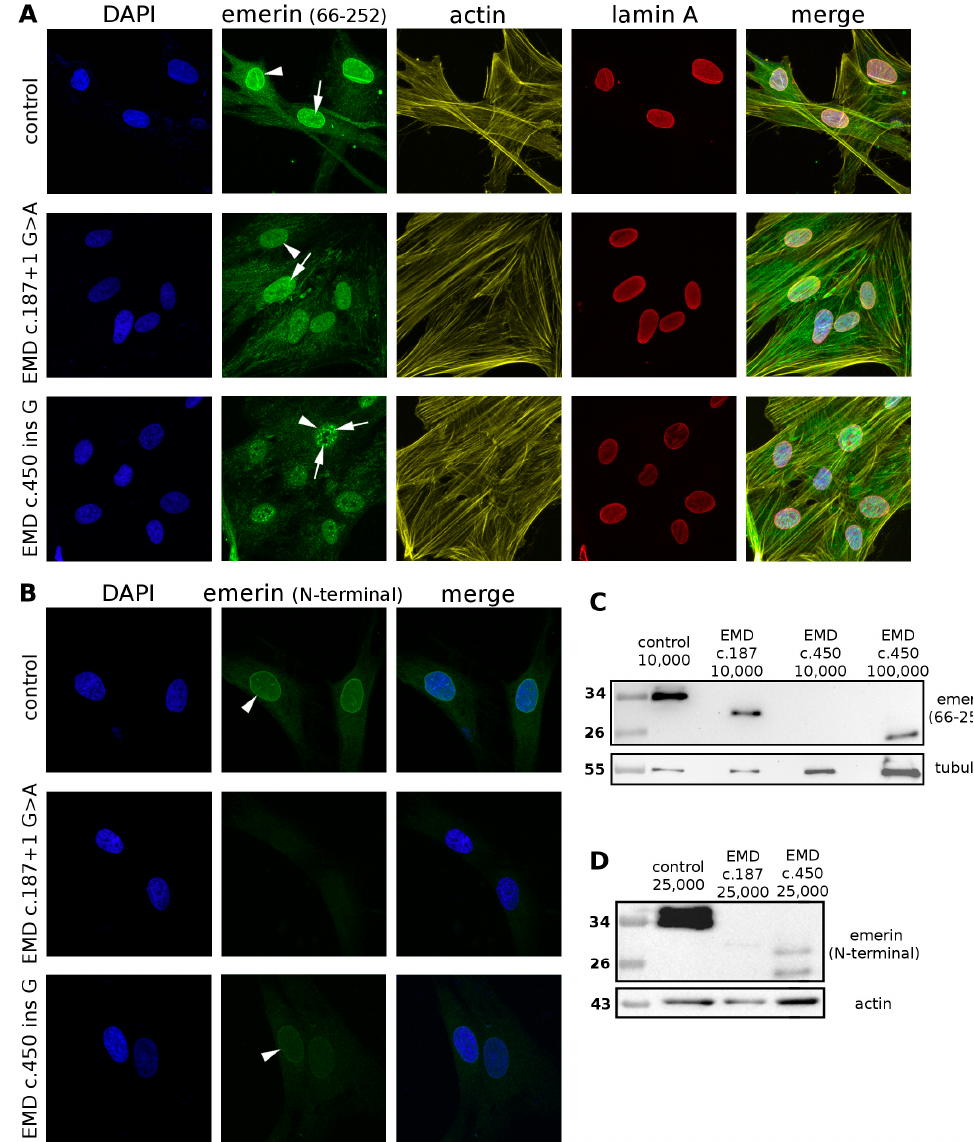
Figure 7. Selected different “emerin-null” patient cells express emerin mutant protein and show abnormal emerin location. Emerin distribution and presence in NHDF and fibroblast obtained from patients with EDMD1. EDMD1 patient cells have shortened emerin with abnormal localization or lower levels. ( A ) Immunofluorescence staining with antibodies recognizing 66–254 aa of emerin indicates changes in the distribution of this protein (emerin diminishing in nuclear rim) in patients bearing mutations c.187 + 1G > A (P2) and c.450insG (P6) in comparison to normal cells. Mutants of emerin do not affect the shape of nuclei (staining for lamin A) or actin filament structure. ( B ) Staining with antibodies recognizing the N-terminus end of emerin indicates lack of epitope in the N-terminal fragment in a patient sample with the mutation c.187 + 1G > A (P2) and shows proper but weaker staining of emerin in the nuclear envelope in a patient sample with the mutation c.450insG (P6), as in the control; the difference in staining pattern between these two antibodies may be because of epitope availability [80] ( C ) Western blot analysis using antibodies recognizing 66–254 aa of emerin shows the presence of truncated proteins in both patients; the level of emerin is lower than in the control. ( D ) Western blot analysis using antibodies recognizing the N-terminal end of emerin shows the low level of truncated proteins in a c.450insG (P6) patient sample; emerin is not detected in a c.187 + 1G > A (P2) patient